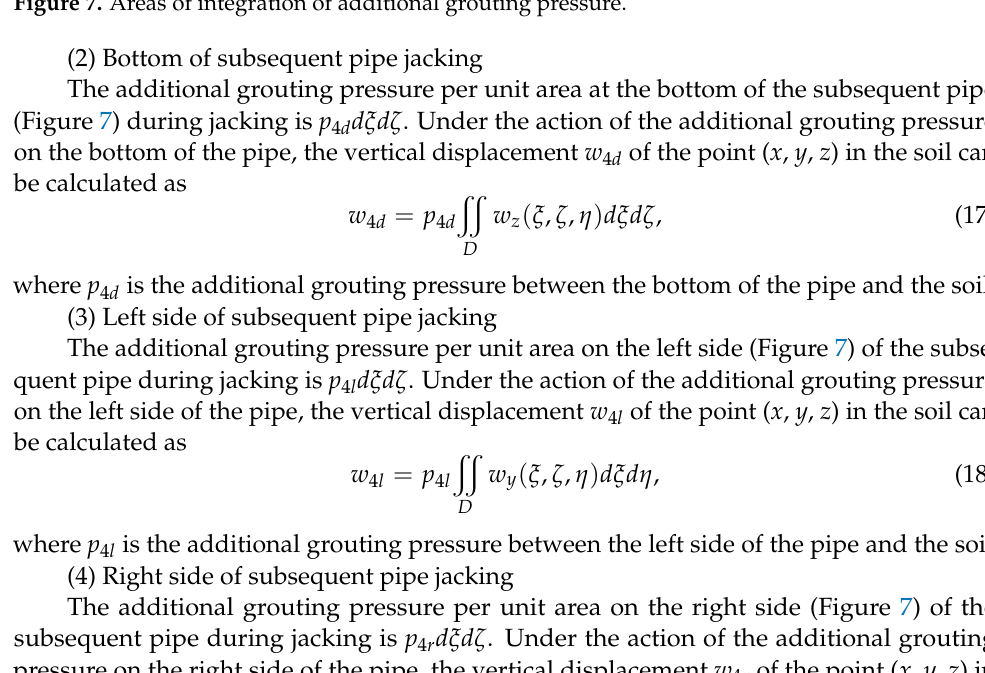
Figure 7. Areas of integration of additional grouting